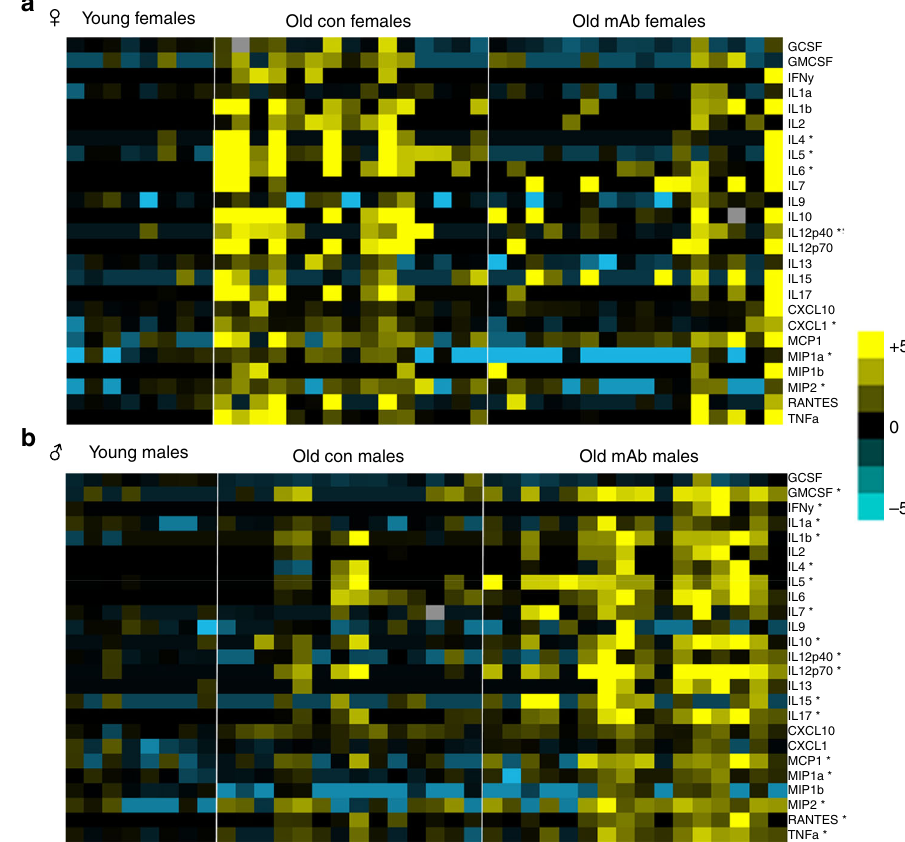
Fig. 5 Sex differences in in fl ammatory markers with IGF-1R mAb treatment in aged mice. a , b A 25-plex cytokine/chemokine panel was performed on plasma obtained from female [Young ( n = 8), Old Con ( n = 15), and Old mAb ( n = 16)] and male mice [Young ( n = 8), Old Con ( n = 14), and Old mAb ( n = 16)]. Data were treated as nonparametric values and analyzed by the Kruskal – Wallis procedure and the Mann – Whitney U -test when appropriate. Any value below the lower limit of detection of the assay was replaced by the minimal detectable concentration (MOD)/ √ 2 for the speci fi c analyte. Therefore, undetectable values were treated as a tie for purposes of statistically ranking data. For generation of the heatmaps, values were normalized against Young Controls and log transformed. Group mean ± s.e.m. for all analytes are provided in Supplementary Tables 6, 7 and raw data found here: [10.17605/OSF.IO/ 8QGX9]. In females, several in fl ammatory mediators, including IL-6, IL-12p-40, and MIP-1 α , were signi fi cantly increased with aging, but were largely restored to more youthful levels with mAb treatment. Meanwhile, systemic in fl ammation in old male mice was markedly exacerbated by mAb treatment, as indicated by a marked increase in the majority of measured analytes over age-matched controls. * P < 0.05 for Old mAb versus Old